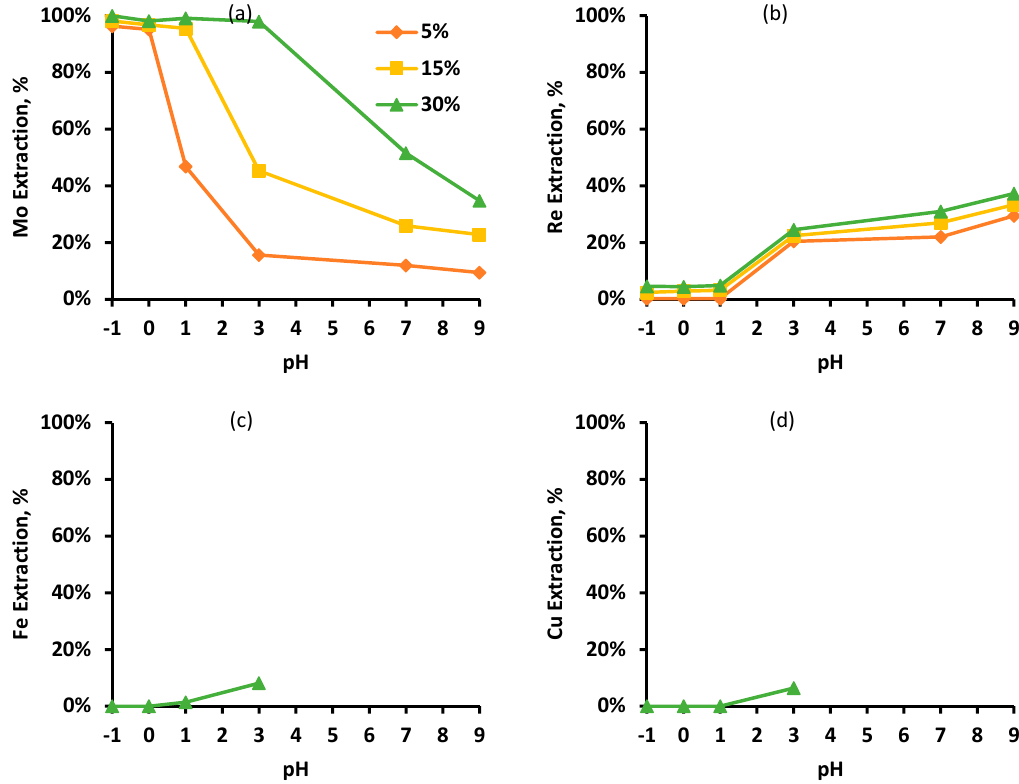
Figure 3. Metal extraction profiles as a function of pH and organic phase concentration: ( a ) Re, ( b ) Mo, ( c ) Fe, and ( d ) Cu.